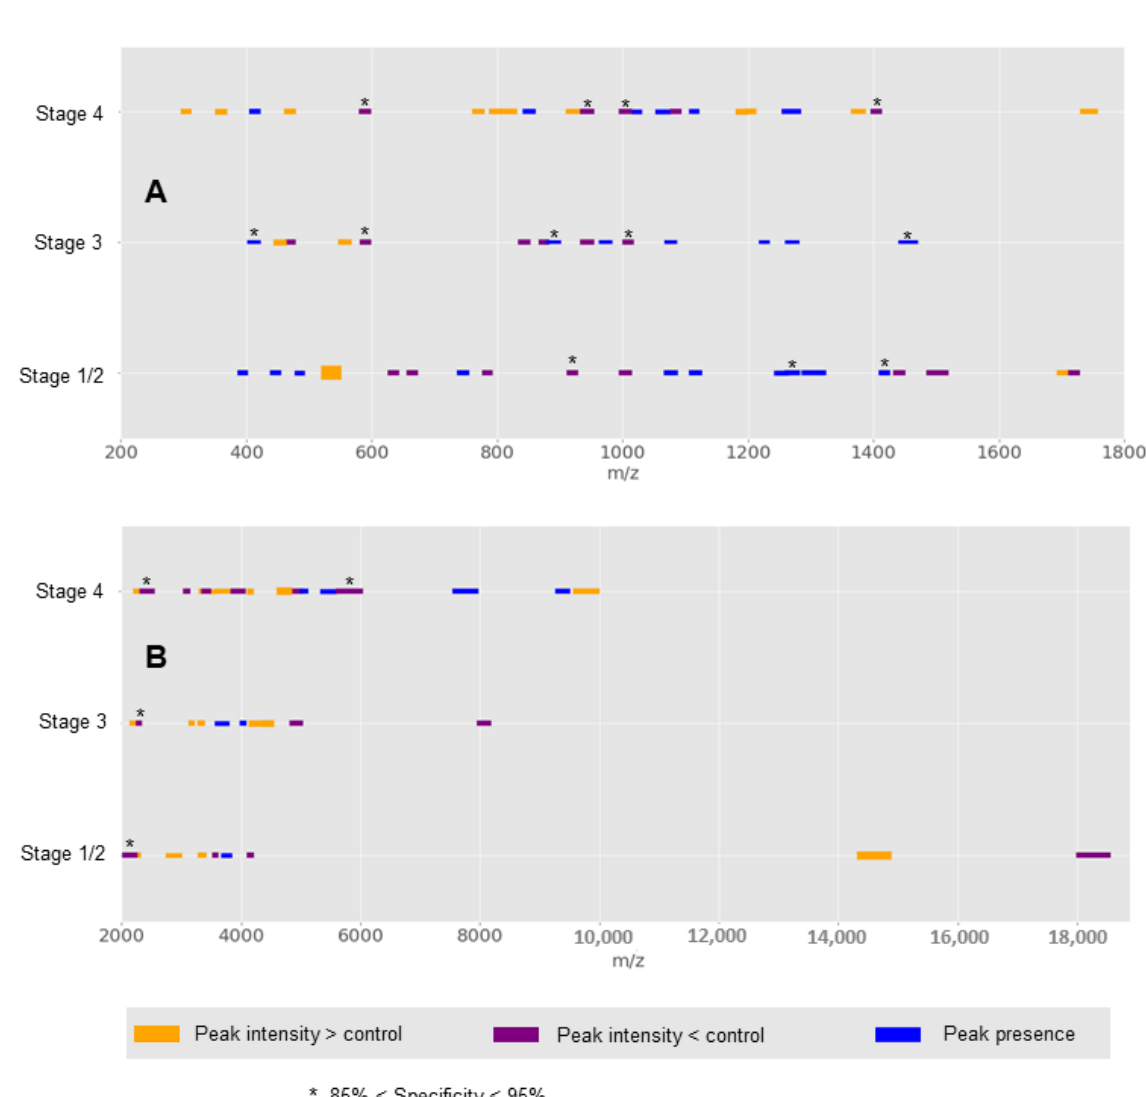
Figure 5. Mass spectral patterns of ovarian cancer classification models. ( A ) Patterns obtained for CHCA matrix mass-spectral-data-derived models. ( B ) Patterns obtained for SA matrix mass-spectral-data-derived models. Classification models correspond to final models evolved through the machine learning process. Orange indicates significant increase in mass spectral intensity in comparison with the control group. Purple indicates a significant reduction in mass spectral intensity in comparison with the control group. Median intensity variation degrees are shown by the broadness of the m / z regions, scaled to be visible for 1 order of magnitude variations. Blue indicates peaks that are characteristic for a given stage (peak presence). The * indicates the mass spectral regions that have an impact on the model’s